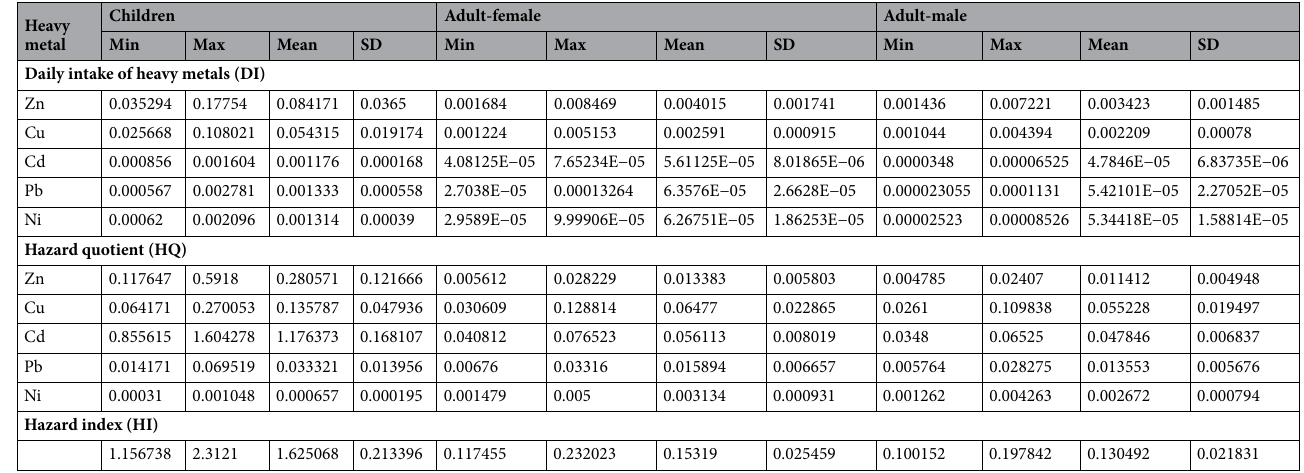
Table 7. Summary statistical attributes of DI, HQ, and HI indifferent age